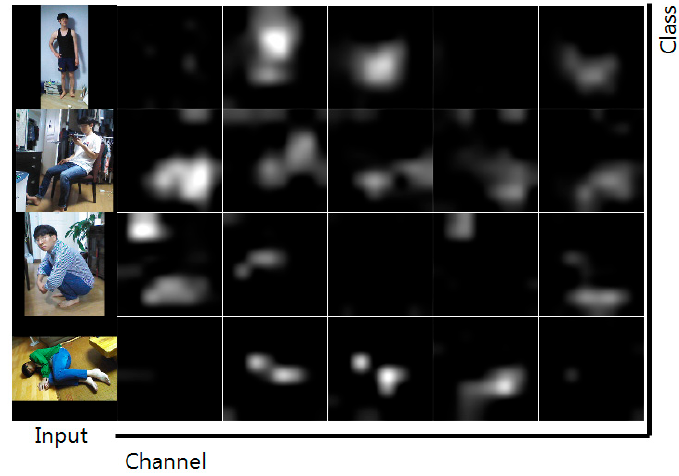
Figure 20. Activations for InceptionResNetV2 with preprocessing of type 2, which exhibited the best performance for the posture data of 11 classes without data augmentation under nontransfer learning: ( a ) activations of first convolution; ( b ) activations of last convolution.